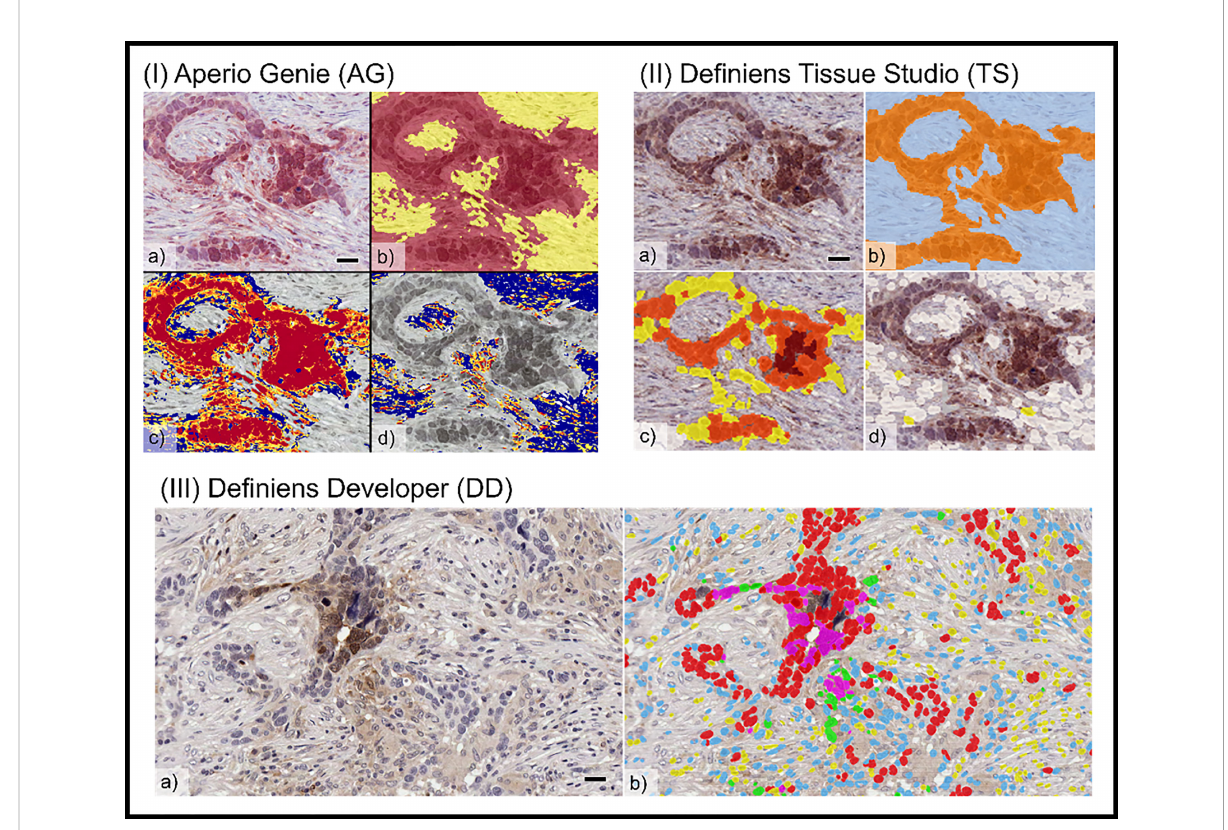
FIGURE 2 Comparison of tumor cellular classi fi cation with image overlay as processed on different image analysis platforms: (I) Aperio Genie: (A) pimonidazole (pimo), IHC (B) epithelial (red), from stroma (yellow) classi fi cation; (C) pimo +ve (red/orange) vs. pimo -ve (blue) in epithelial tumor; (D) pimo+ (red/orange) vs. pimo -ve (blue) in stromal tumor. (II) De fi niens Tissue Studio: (A) pimonidazole IHC; (B) epithelial (orange) from stroma (light blue) classi fi cation; (C) pimo +ve (brown/orange/yellow) from pimo -ve (white) in epithelial compartment; (D) pimo+ (brown/ orange/yellow) from pimo -ve (white) in stromal compartment; and (III) De fi niens Developer: (A) pimonidazole IHC; (B) segmented cell overlay with pimo +ve epithelial cells (pink), pimo -ve epithelial cells (red), pimo +ve stromal cells (green), pimo -ve stromal cells (blue), in fl ammatory/ other